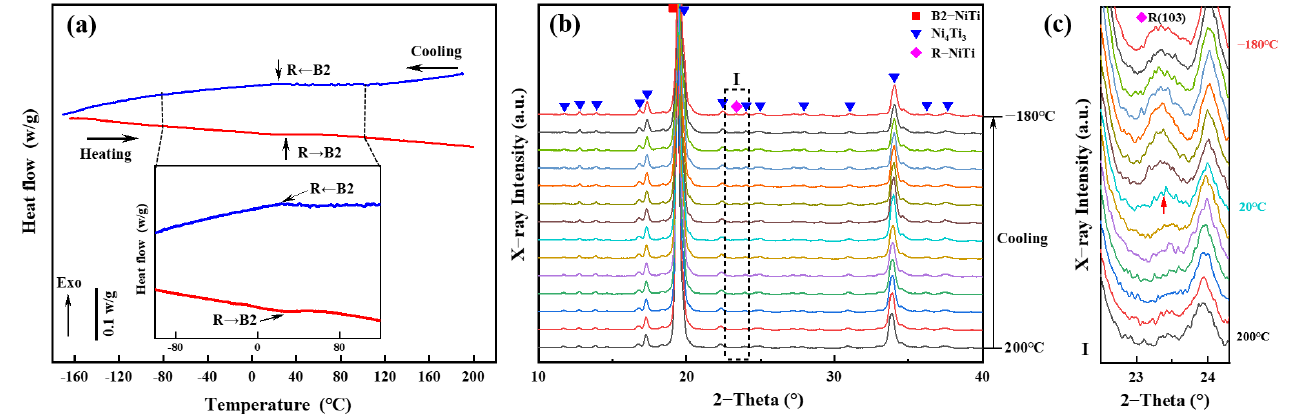
Figure 2. ( a ) The DSC curve of the 60NiTi sample; ( b ) one − dimensional XRD patterns during cooling; and ( c ) enlarged views of the corresponding lines in the dotted box of ( b ).